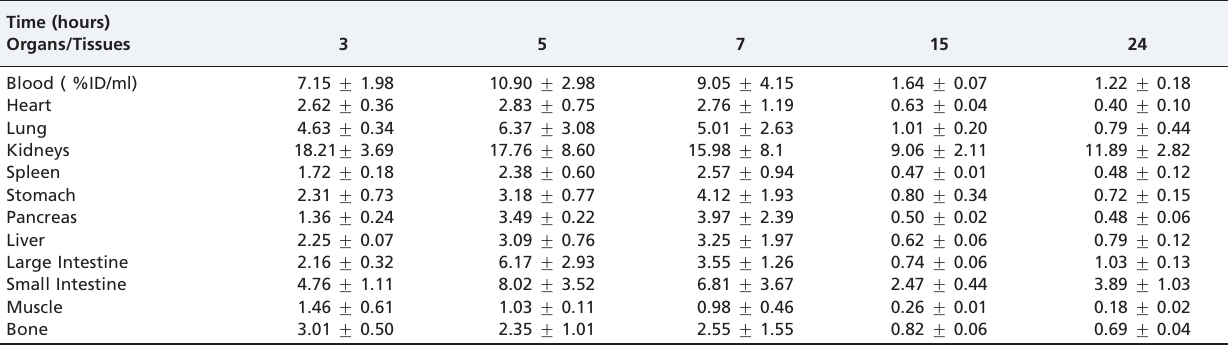
Table 3 - Biodistribution of (SA + B-MORF + B -PEG -BBN) plus 99m Tc-MAG 3 -cMORF by pretargeting system in healthy animals.